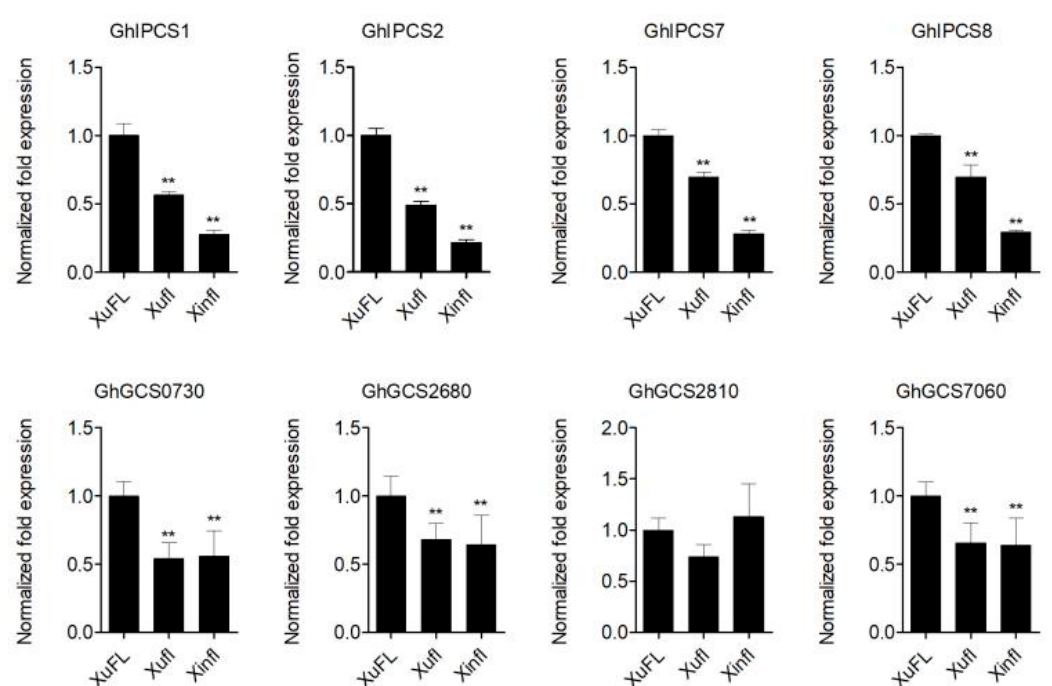
Figure 6. The differential gene expression for GluCer and IPC synthesis between wild-type and two mutants. GhIPCS1 , GhIPCS2 , GhIPCS7 , and GhIPCS8 are homologues of IPCS (phosphatidylinositol ceramide synthase) in cotton genome. GhGCS0730 , GhGCS2680 , GhGCS2810 , and GhGCS7060 are homologues of GCS (GluCer synthase) in cotton genome. XuFL, wild-type Xuzhou 142; Xufl , Xuzhou 142 lintless-fuzzless mutant; Xinfl , Xinxiangxiaoji lintless-fuzzless mutant. Three independent RNA isolations were used for cDNA synthesis, and each cDNA sample was subjected to quantitative real-time PCR analysis in triplicate. Error bars represent the SD. Statistical data analysis was performed by the one-tailed student’s t -test. ** indicate significant differences at p < 0.01.